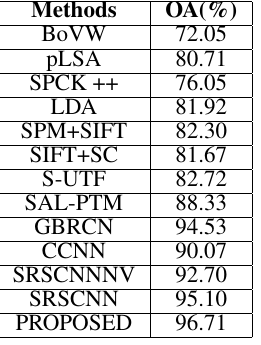
Table 1. Comparison of the previous reported accuracies with